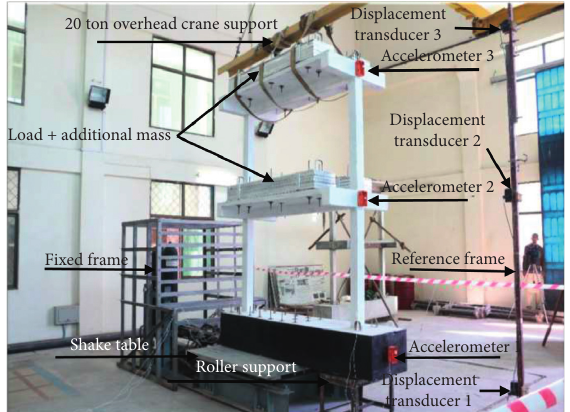
Figure 2: Instrumentation of the test model for acceleration and displacement